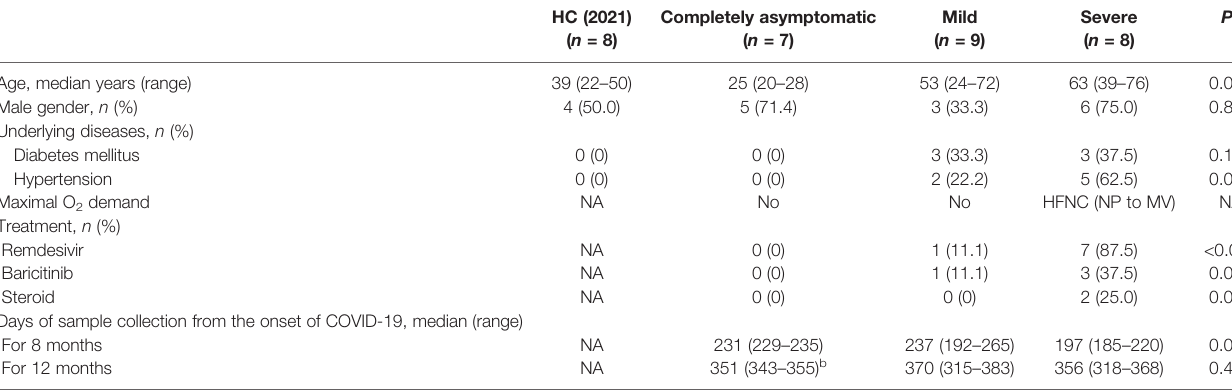
TABLE 1 | Clinical characteristics of patients included in analyses for 1 year